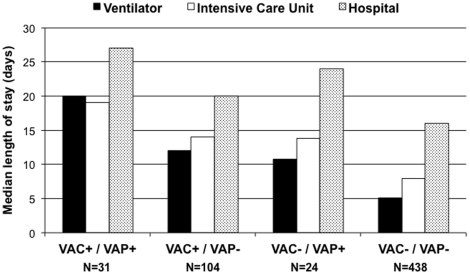
Median ventilator, intensive care unit, and hospital lengths of stay according to overlap pattern between patients with ventilator-associated complications (VAC) versus ventilator-associated pneumonia (VAP).